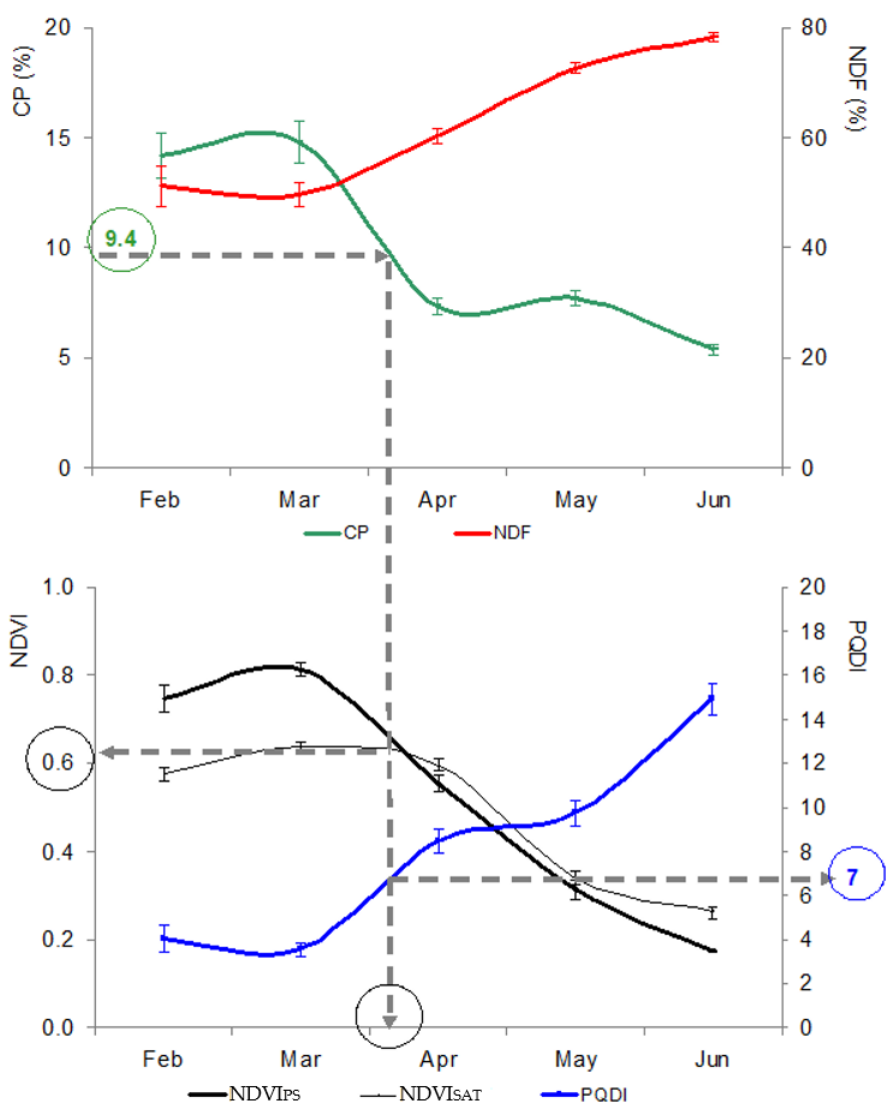
Figure 4. Evolution, between February and June 2017, of pasture nutritive value parameters (crude protein, CP; neutral detergent fiber, NDF; and pasture quality degradation index, PQDI) and vegetation index (obtained from proximal sensor, NDVI PS ; and from satellite, NDVI SAT ). Data are average values of the twelve sampling points. The arrows indicate the sheep maintenance requirements in terms of CP (9.4%) and their correspondence with PQDI (7 in this case) and with NDVI (0.6 in this case).